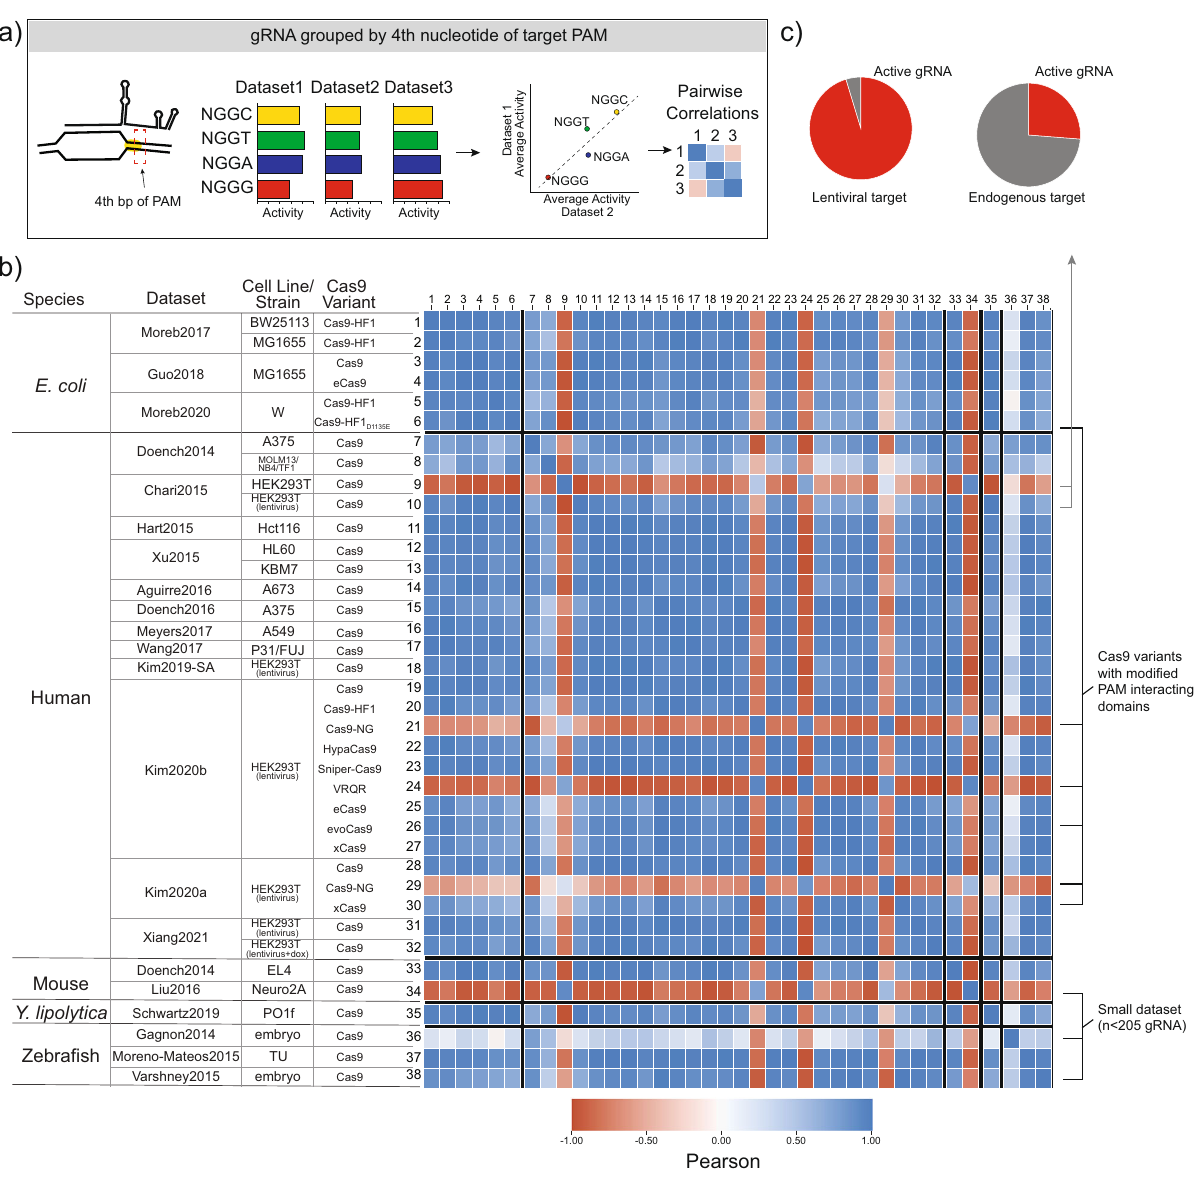
Fig. 3 Validation of Cas9 PAM preference as an intrinsic feature of Cas9 activity. a Cas9 has been reported to have a slight preference for NGGH PAM sites, where H is either A, C, or T. We grouped gRNA by the 4th nucleotide of the PAM site, calculated the average activity per group, and correlated the averaged values between datasets in a pairwise fashion. Pairwise correlations between all datasets show strong agreement in relative activity, con fi rming the preference for NGGH. Exceptions to this are well-explained and include datasets using Cas9 variants with modi fi ed PAM preferences or particularly small datasets which may not have the statistical power to capture known features. c Additionally, in Chari et al. 2015, most of the gRNA targeting endogenous sites showed no activity, overriding any impact that PAM preference may have. Among all datasets, three datasets did not have sequence variability in the 4th nucleotide of the PAM and were therefore excluded from this analysis: Wang et al. 2019, Tálas et al. 2021, and Park et al.